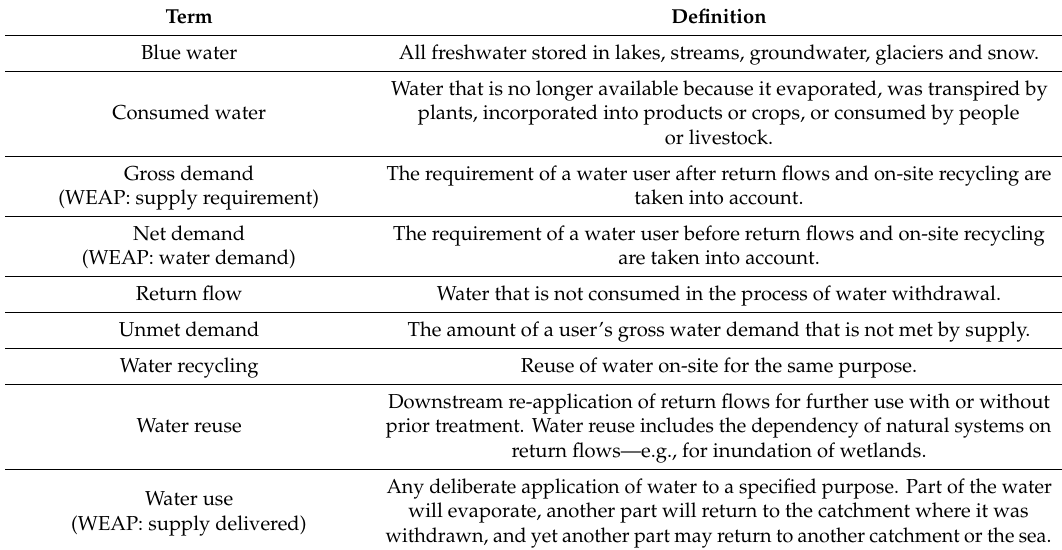
Table A1. List of water balance terms used and their definitions. Where applicable, corresponding WEAP terminology is indicated between